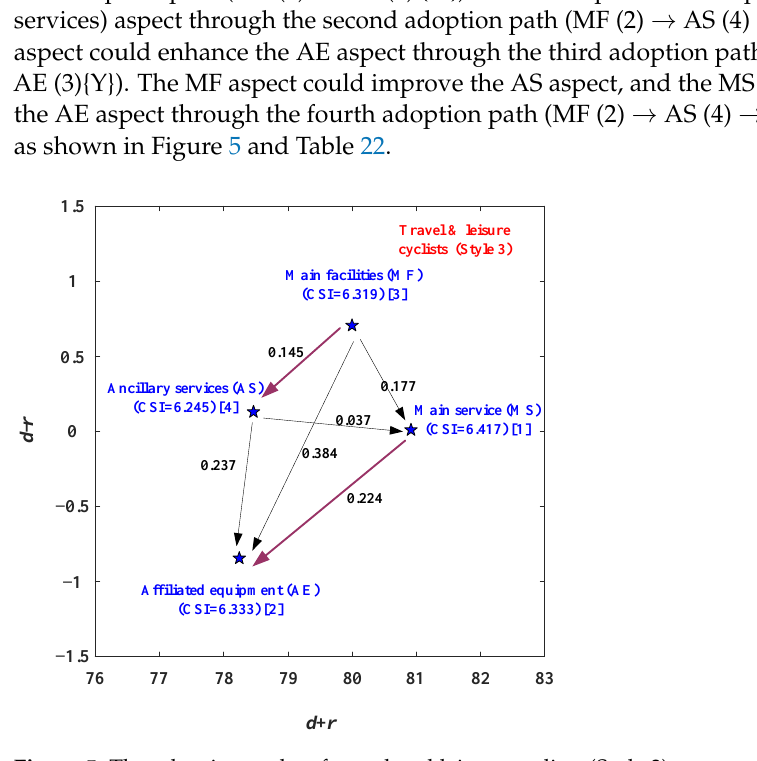
Figure 5. The adoption paths of travel and leisure cyclists (Style 3). Table 22. The adoption paths of travel and leisure cyclists (Style 3). Travel and Leisure Cyclists (Style 3)